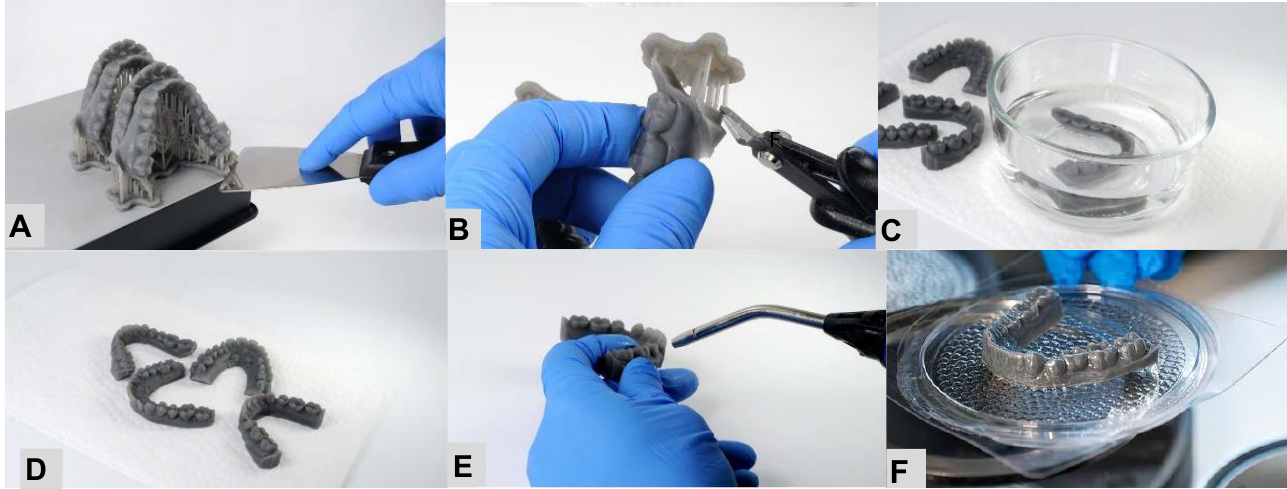
Figure 19. Post-printing process. ( A ), Model removal from printer platform; ( B ) support removal; ( C ), 2-propanol bath; ( D , E ), air drying at room temperature; ( E , F ), thermoforming procedure.